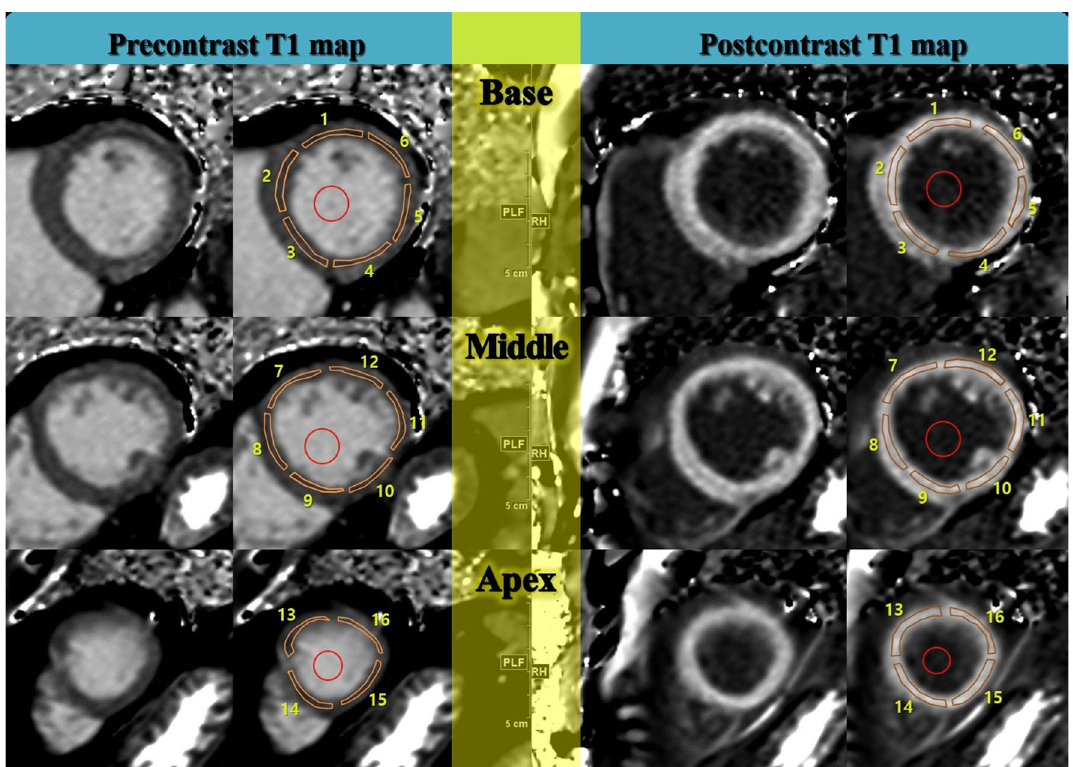
Figure 5. Short-axis slices of pre-contrast and post-contrast reconstructed T1 maps. The corresponding regions of interest on left ventricular segments and cavity blood (red circles) were drawn on T1 maps in a 54-year-old male in the control